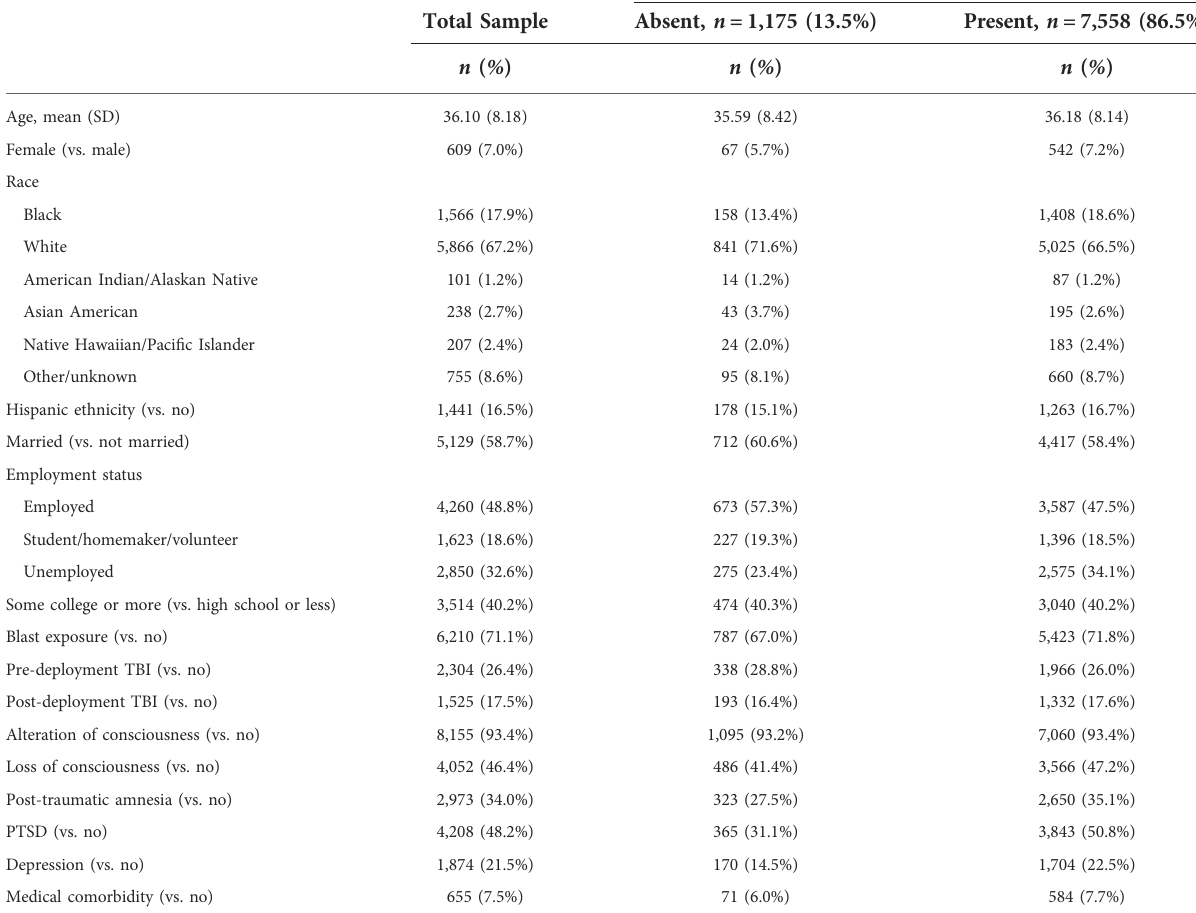
TABLE 1 Characteristics of Veterans with mTBI ( n